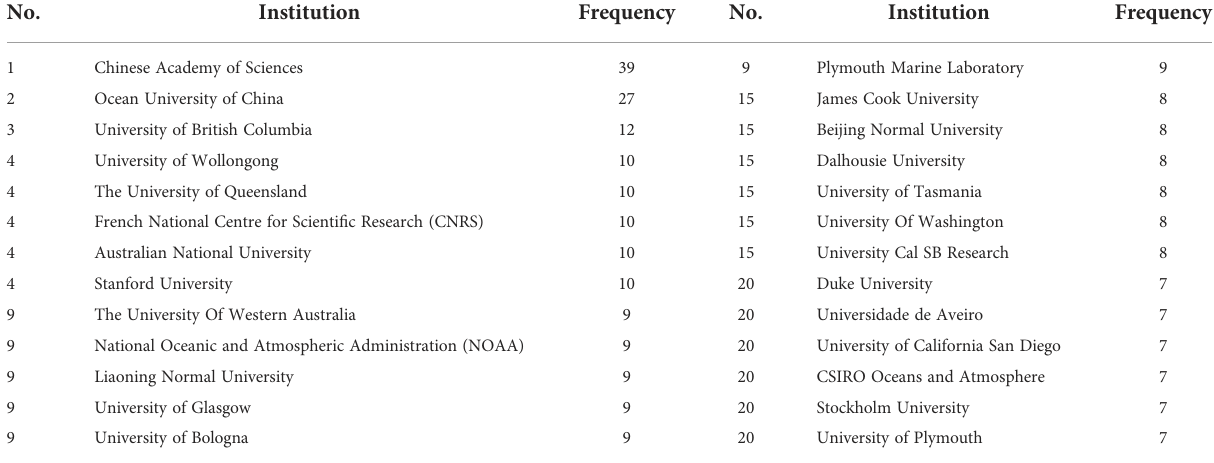
TABLE 5 List of institutions based on frequency ≥ 7.